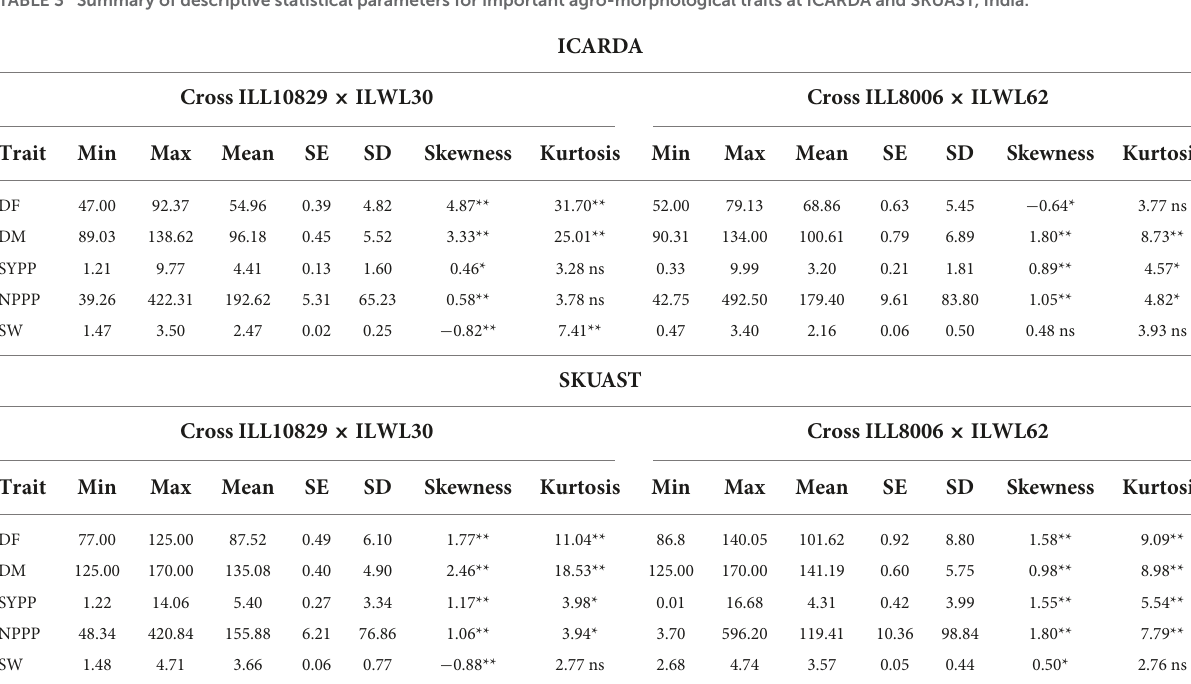
TABLE 3 Summary of descriptive statistical parameters for important agro-morphological traits at ICARDA and SKUAST,